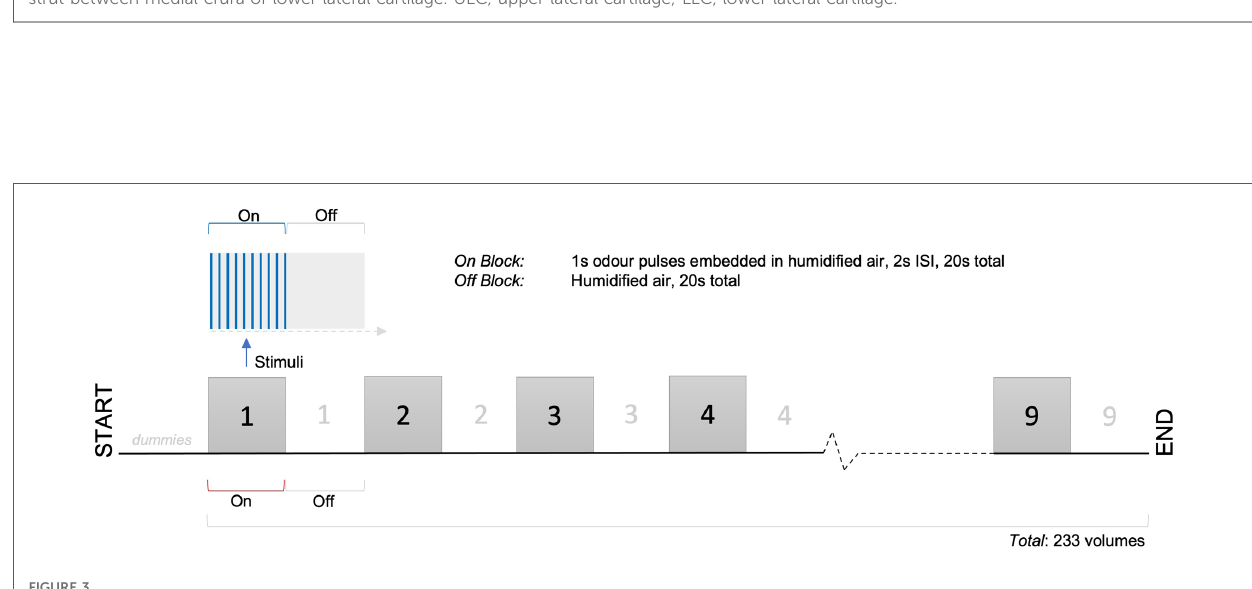
FIGURE 3 fMRI experimental